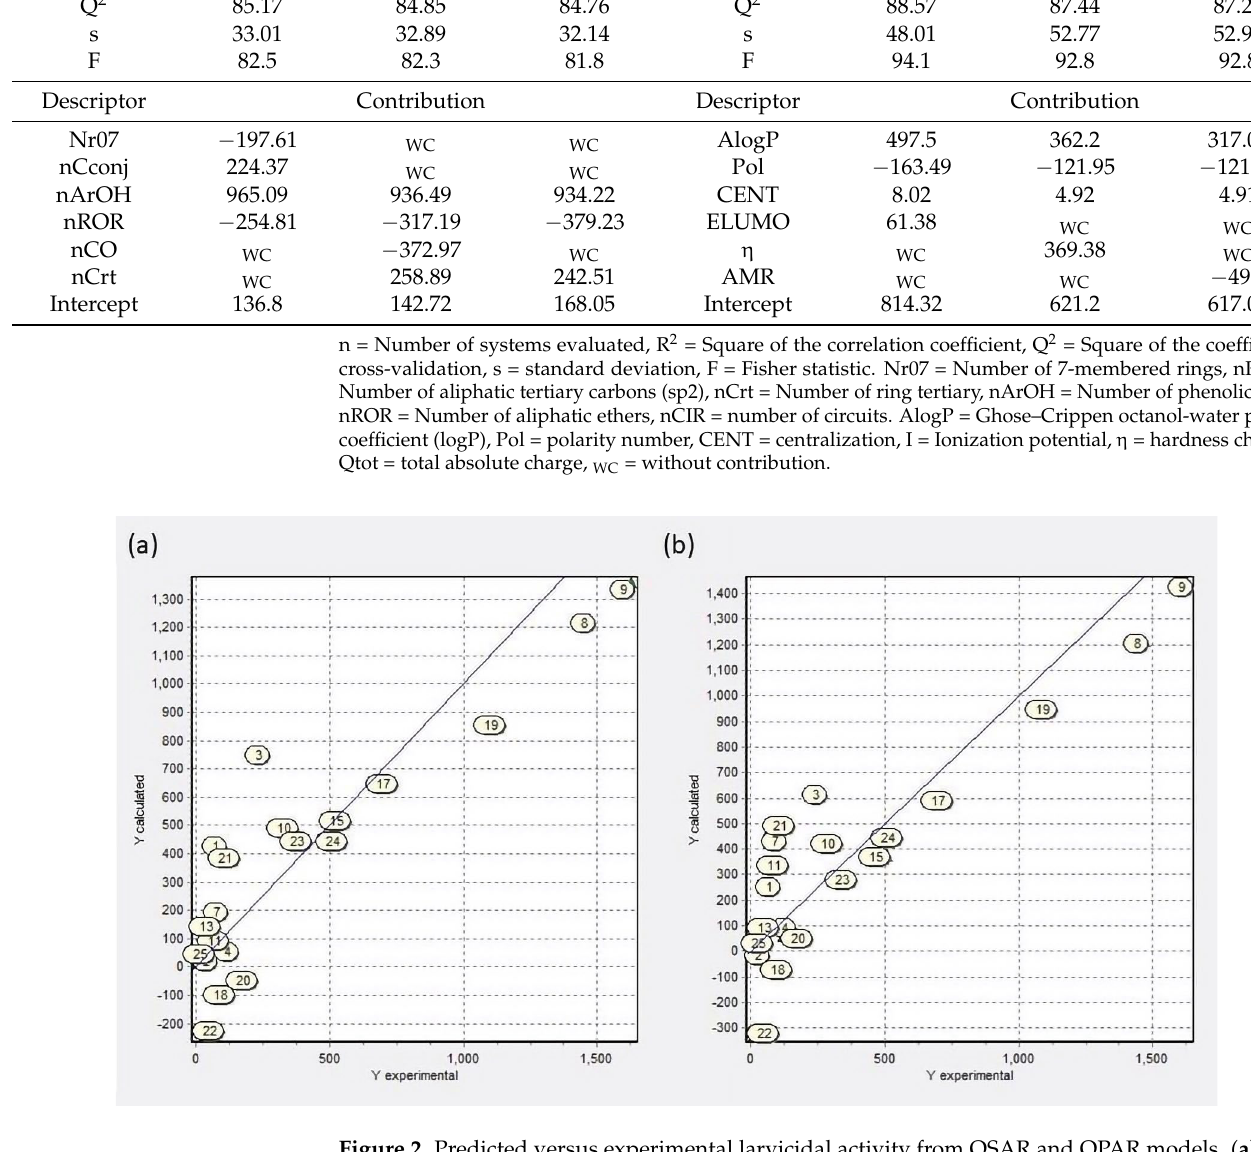
Figure 2. Predicted versus experimental larvicidal activity from QSAR and QPAR models. ( a ) Quan- titative structure–activity relationship (QSAR) models from larvicidal activity; ( b ) quantitative property–activity relationship (QPAR) models from larvicidal activity. Table 3. Structural parameters used to derive QSAR models.